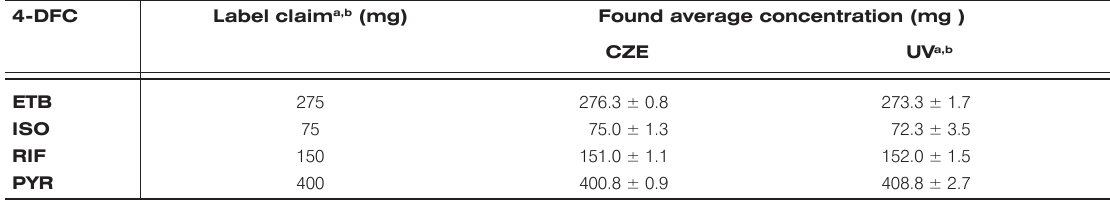
Table 4. Average of values found by CZE and UV spectrophotometry (n=7) for 4-FDC tablets. 4-DFC